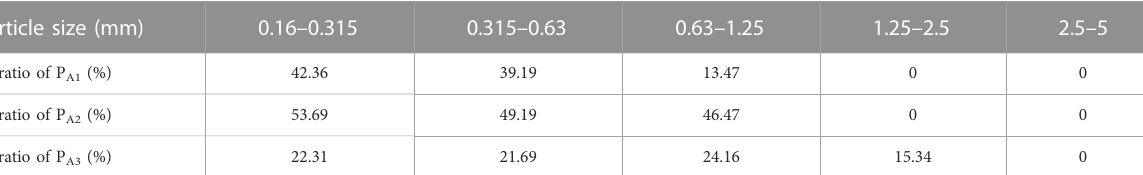
TABLE 6 Mass of each particle size range of the clogging material in the specimen.